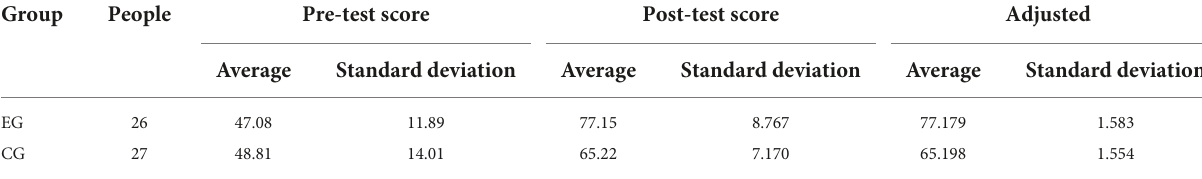
TABLE 3 The ANCOVA analysis of pre-test and post-test results of learning effectiveness. Group